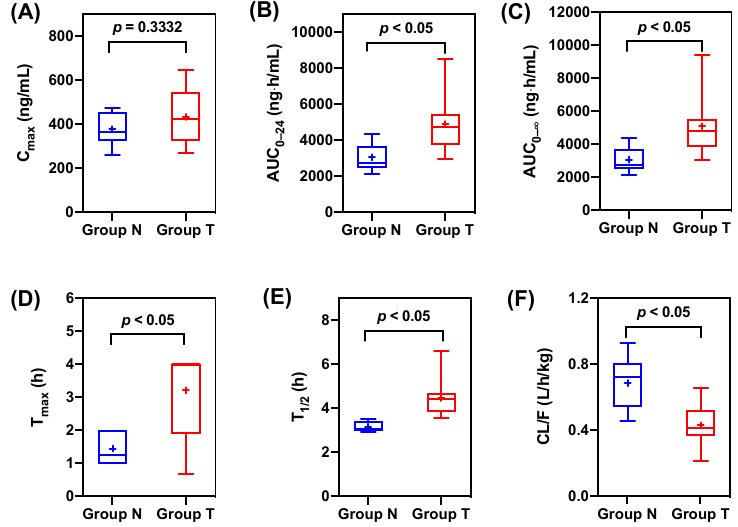
Figure 2. Comparisons of the non-compartment analysis parameters of tadalafil from non-pretreated rats (Group N) and ticagrelor-pretreated rats (Group T). Boxes mean 25th and 75th percentiles of data and whiskers mean 5th and 95th percentiles of data. The median and mean values are displayed as a solid line (–) and a plus mark ( + ) in boxes, respectively. ( A ) C max ; ( B ) AUC 0–24 ; ( C ) AUC 0– ∞ ; ( D ) T max ; ( E ) T 1 / 2 ; ( F ) CL / F. Maximum concentration (C max ); area under the plasma concentration vs. time curve from 0 to 24 h (AUC 0–24 ); area under the plasma concentration vs. time curve from 0 to infinity (AUC 0– ∞ );time to reach maximal concentration (T max ); half-life (T 1 / 2 ); apparent total clearance (CL / F).